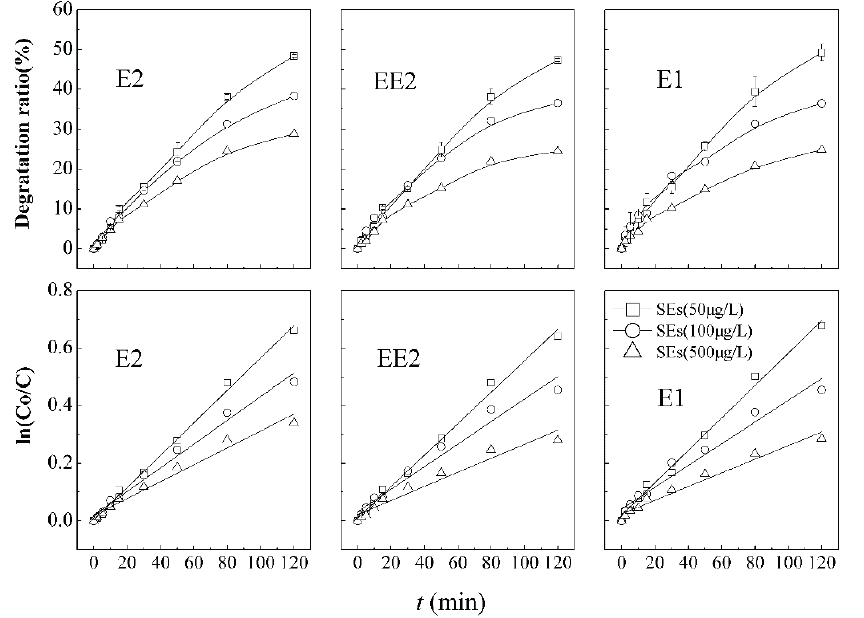
Figure 4. Degradation curves and first order kinetic models of SEs in combined processes under different initial